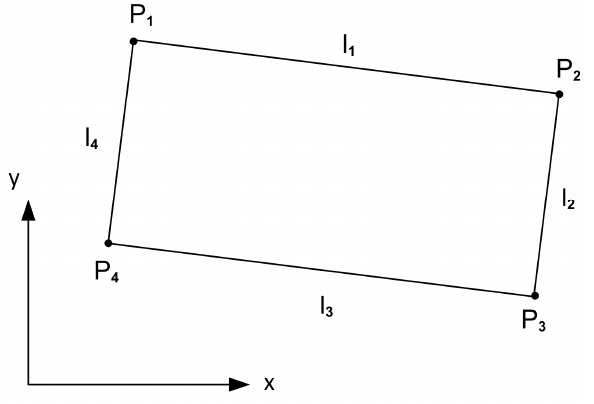
Figure 5. Sketch of building outlines and corner points.